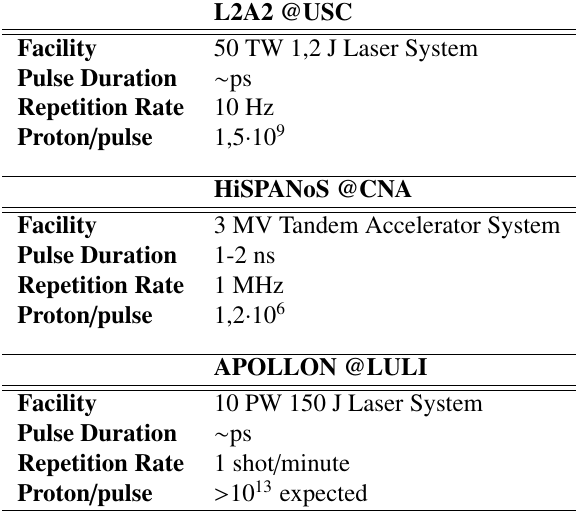
Table 1. Summary of the characteristics of the facilities for the first stage of the